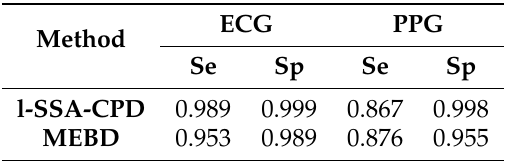
, Q = 1) and Pflugradt et al.’s [52] n , I , p , q